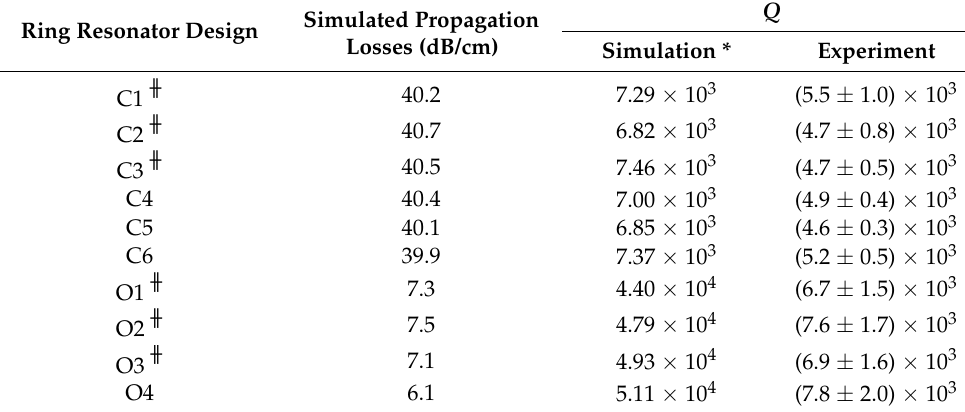
Table 4. Comparison of SWG ring resonator propagation losses and critically coupled quality factors predicted by 3D-FDTD simulations with experimentally measured quality factors. Simulations and experimental characterization were performed with water cladding. Experimental quality factors are reported for the ring resonator designs with the best-performing coupling gaps, as listed in Table 3. Experimental quality factors for each sensor geometry were calculated from 0–13 resonance peaks per resonator (those peaks passing the R 2 > 0.85 threshold) analyzed over a wavelength range of Table 2. Group index, n g , and free spectral range ( FSR ) for SWG ring resonators obtained from 3D- 1530–1560 nm for the C-band devices and 1270–1310 nm for the O-band devices, with 1–2 replicate FDTD band structure simulations with as-designed structures and experiments. For each resonator, resonators on each of five replicate chips. Experimental quality factors are reported as the mean ± one Table 2. Group index, n g , and free spectral range ( FSR ) for SWG ring resonators obtained from 3D- n g and FSR were calculated based on all resonances measured over a wavelength range of 1530– FDTD band structure simulations with as-designed structures and experiments. For each resonator, standard deviation. Further details regarding the number of included resonance peaks per resonator Table 2. Group index, n g , and free spectral range ( FSR ) for SWG ring resonators obtained from 3D- 1560 nm for the C-band devices and 1270–1310 nm for the O-band devices. The reported values are n g and FSR were calculated based on all resonances measured over a wavelength range of 1530– on each chip are provided in Table S1. FDTD band structure simulations with as-designed structures and experiments. For each resonator, the mean ± one standard deviation for these measurements from five replicate chips. 1560 nm for the C-band devices and 1270–1310 nm for the O-band devices. The reported values are n g and FSR were calculated based on all resonances measured over a wavelength range of 1530– the mean ± one standard deviation for these measurements from five replicate chips. 1560 nm for the C-band devices and 1270–1310 nm for the O-band devices. The reported values are the mean ± one standard deviation for these measurements from five replicate chips. Table 2. Group index, n g , and free spectral range ( FSR ) for SWG ring resonators obtained from 3D- FDTD band structure simulations with as-designed structures and experiments. For each resonator, Table 2. Group index, n g , and free spectral range ( FSR ) for SWG ring resonators obtained from 3D- n g and FSR were calculated based on all resonances measured over a wavelength range of 1530– FDTD band structure simulations with as-designed structures and experiments. For each resonator, Table 2. Group index, n g , and free spectral range ( FSR ) for SWG ring resonators obtained from 3D- 1560 nm for the C-band devices and 1270–1310 nm for the O-band devices. The reported values are n g and FSR were calculated based on all resonances measured over a wavelength range of 1530– FDTD band structure simulations with as-designed structures and experiments. For each resonator, the mean ± one standard deviation for these measurements from five replicate chips. 1560 nm for the C-band devices and 1270–1310 nm for the O-band devices. The reported values are n g and FSR were calculated based on all resonances measured over a wavelength range of 1530– Table 2. Group index, n g , and free spectral range ( FSR ) for SWG ring resonators obtained from 3D- the mean ± one standard deviation for these measurements from five replicate chips. 1560 nm for the C-band devices and 1270–1310 nm for the O-band devices. The reported values are FDTD band structure simulations with as-designed structures and experiments. For each resonator, the mean ± one standard deviation for these measurements from five replicate chips. n g and FSR were calculated based on all resonances measured over a wavelength range of 1530– 1560 nm for the C-band devices and 1270–1310 nm for the O-band devices. The reported values are the mean ± one standard deviation for these measurements from five replicate